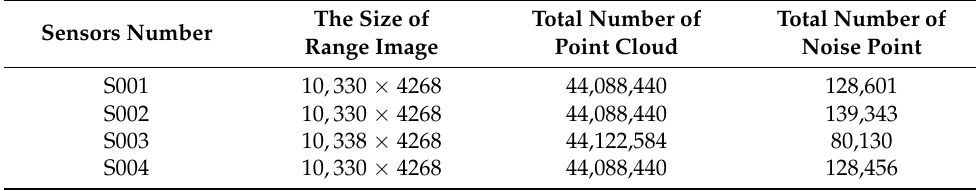
Table 3. Point number of point